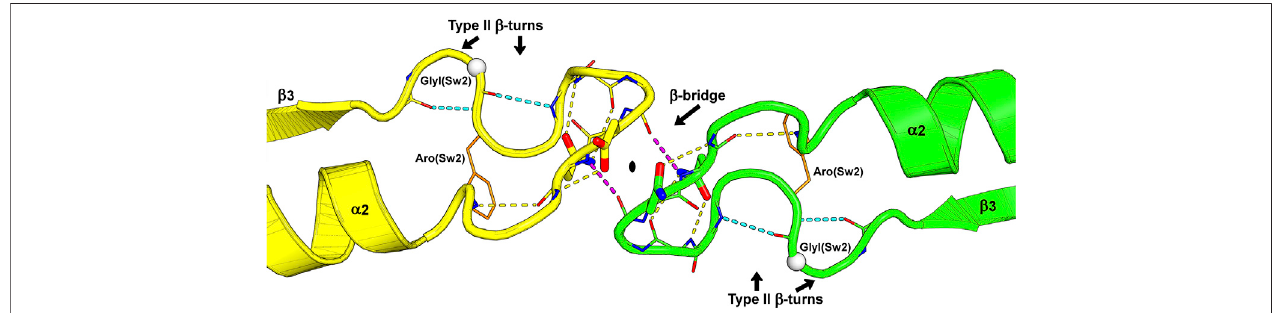
FIGURE 4 | The switch II region at the G-interface of the SEPT7-SEPT3 heterodimer (PDB:6UQQ). An essentially identical arrangement is observed at all physiological G-interfaces. The wide-type β -bridge, which lies on thepseudo-twofold symmetry axis relatingthe twomonomers, islabeled, and its two hydrogen bonds are colored in purple. Over the β -bridge, an aspartic acid in SEPT7 (yellow) and an asparagine in SEPT3 (green), i.e., the positions Asx(Sw2), are represented as sticks and positioned on opposite sides of the symmetry axis (black lozenge at the center). Under the β -bridge, each subunit presents an asparagine residue, Asn(Sw2), whose side chain is represented as sticks, forming hydrogen bonds to both the main chain nitrogen and oxygen atoms of the residue three positions prior in the sequence. In each subunit, two consecutive type II β -turns forming an “ S ” shape are labeled, and their hydrogen bonds are colored in cyan. Some side chains and main chain atoms were removed for clarity. Aro(Sw2) is indicated as it may play a role in communication between adjacent interfaces and GlyI(Sw2) is represented as a white sphere.